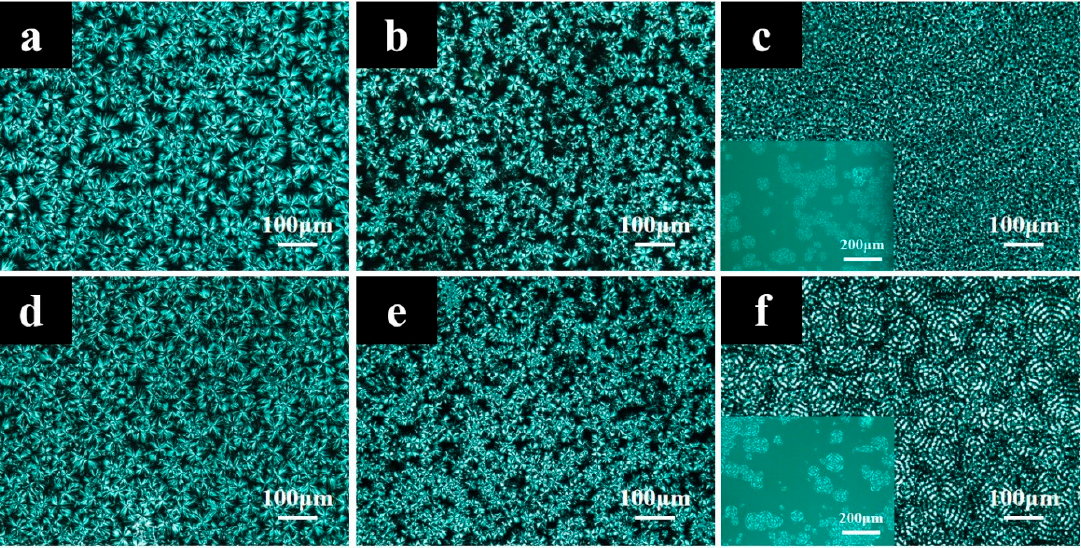
Figure 5. Polarized optical microscopy images of C 90 - co -A 10 ( a , d ), C 75 - co -A 25 ( b , e ) and C 50 - co -A 50 ( c , f ) after isothermal crystallization directly at 40 °C ( a – c ) and firstly at 160 °C and then at 40 °C ( d – f ). Polymers 2020 , 12 , x FOR PEER REVIEW